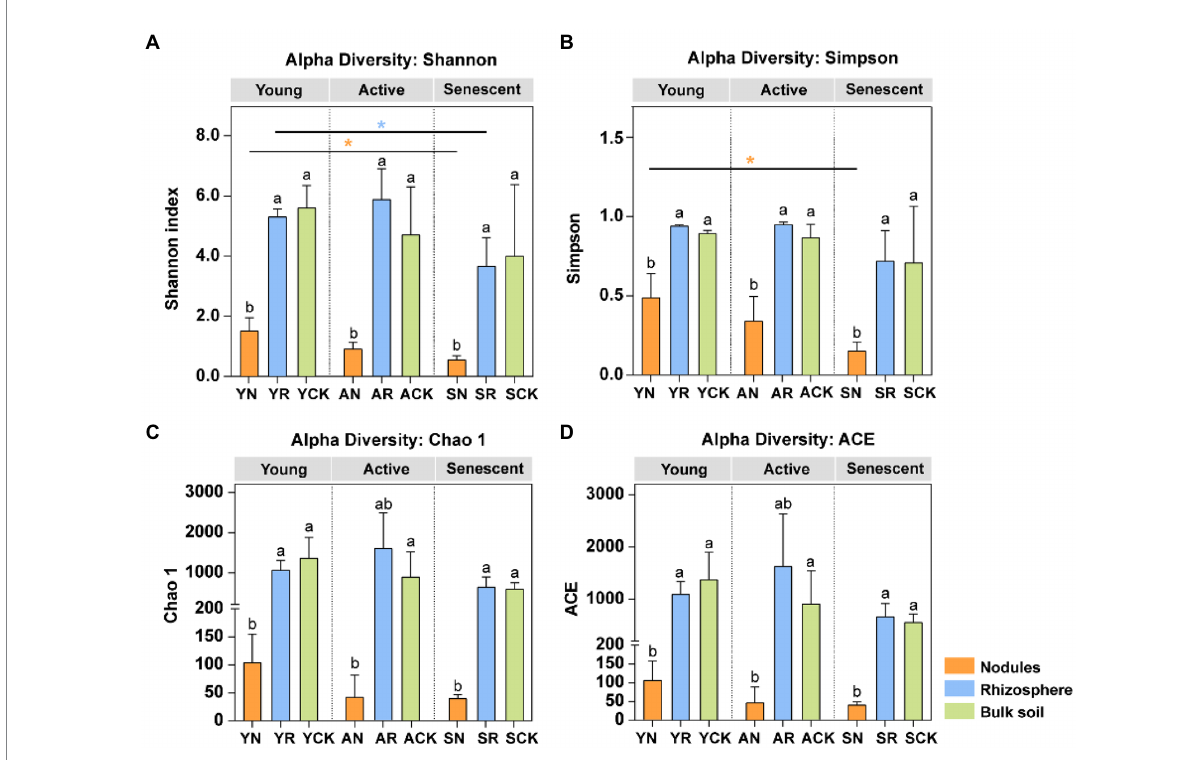
FIGURE 2 Richness and diversity of the diazotrophic community of the various compartments and phases. (A) Shannon index; (B) Simpson index; (C) Chao 1; (D) ACE. Lowercase letters above the bars indicate significant differences ( p < 0.05) between the different compartments in three phases, respectively (One-way ANOVA test). Asterisks indicate significant differences between three phases in the same compartment (Tukey test). *, p < 0.05; **, p < 0.01; ***, p <